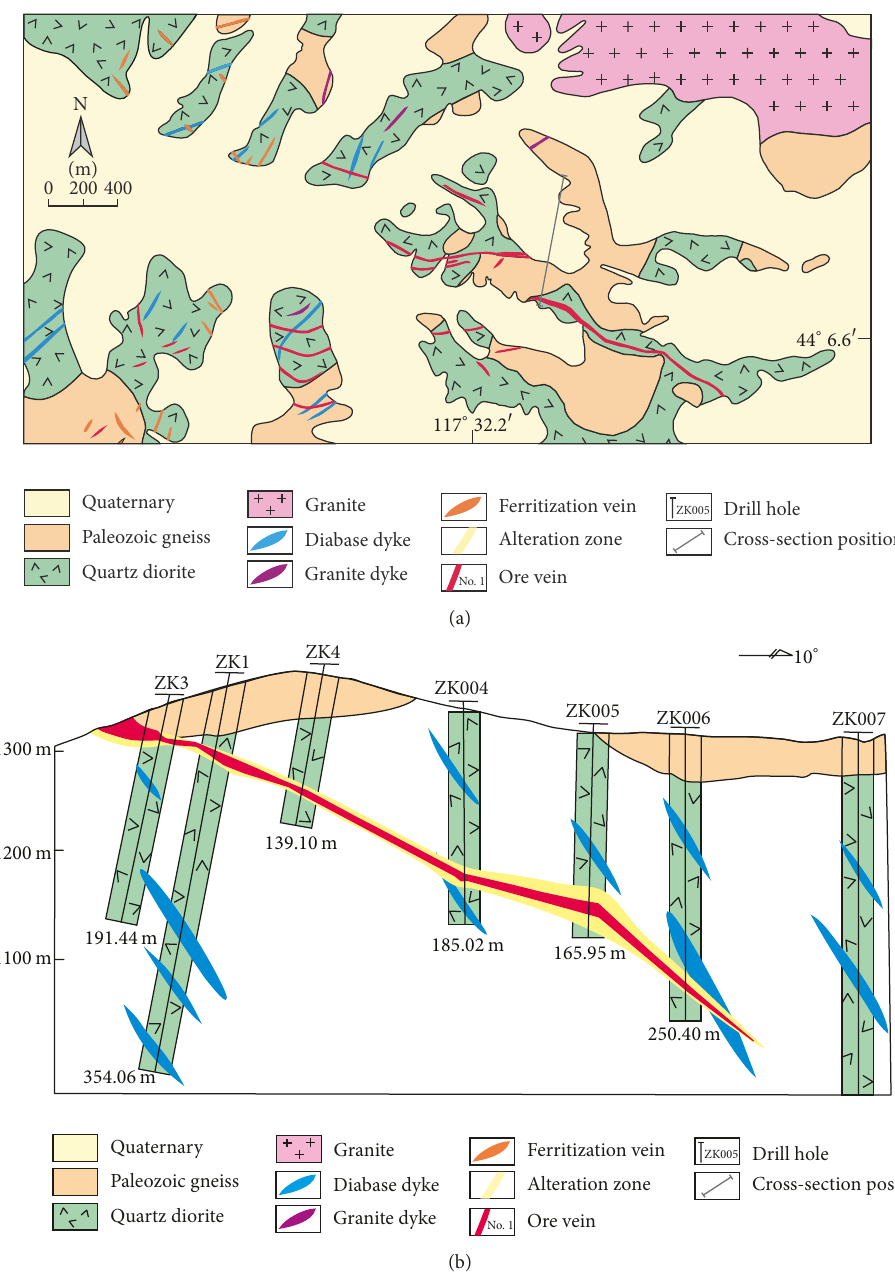
Figure 2: (a) Geological map of the Bairendaba Ag-Zn-Pb deposit (after the Ninth Geological Prospecting Institute of Inner Mongolia 2004). (b) Geological cross-section of the number 1 ore body (after the Ninth Geological Prospecting Institute of Inner Mongolia 2004).